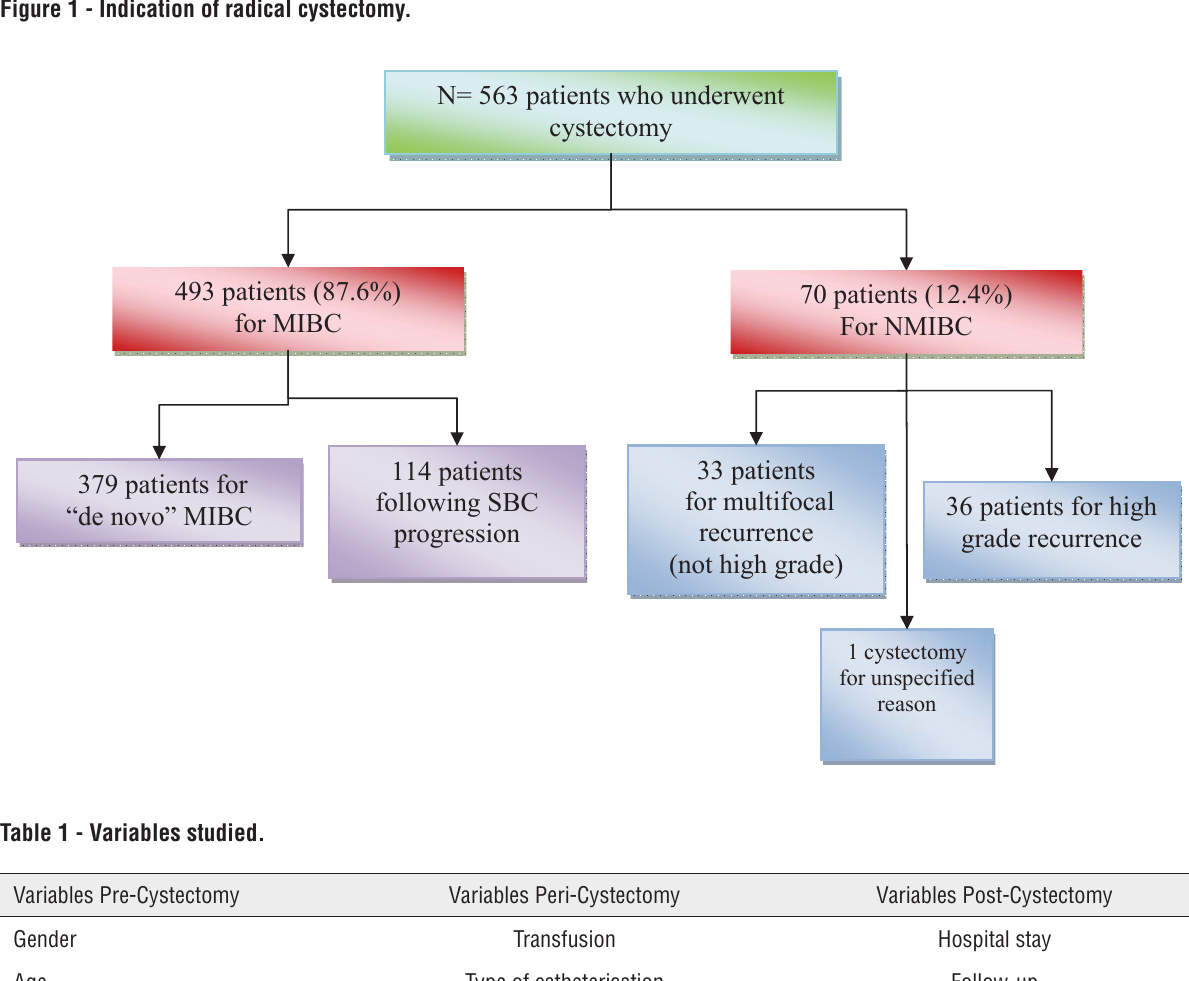
Figure 1 - Indication of radical cystectomy.